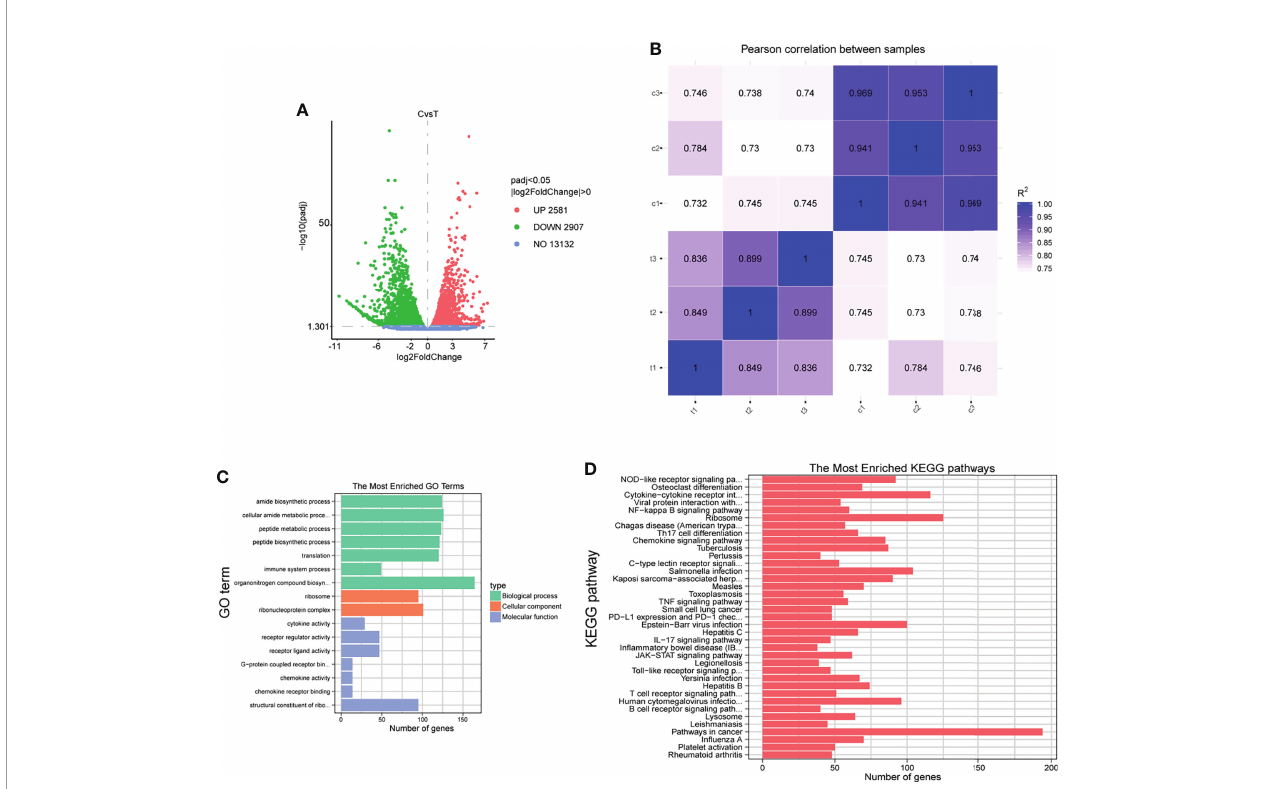
FIGURE 6 | RNA-sequencing analysis of sheep neutrophils cells stimulated with F. necrophorum (MOI of 100). (A) The number of DEGs in six samples after F. necrophorum stimulation at 4 h. (B) Pearson correlation between samples. (C) GO enrichment analysis of the DEGs. (D) KEGG enrichment analysis of the DEGs. ( n = 3).